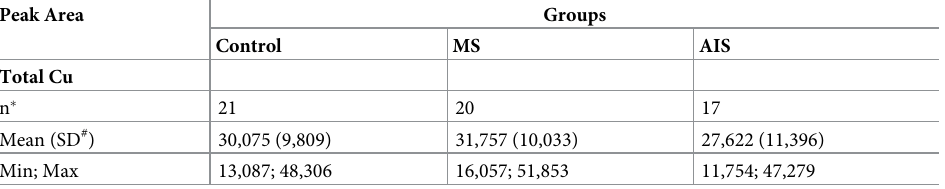
Table 4. Mean Zn area values, standard deviations and minimum/maximum values obtained for the analysis of serum samples by SEC-ICP-AES for total Zn and ɑ 2 M (outliers removed). Peak Area Groups Control MS AIS